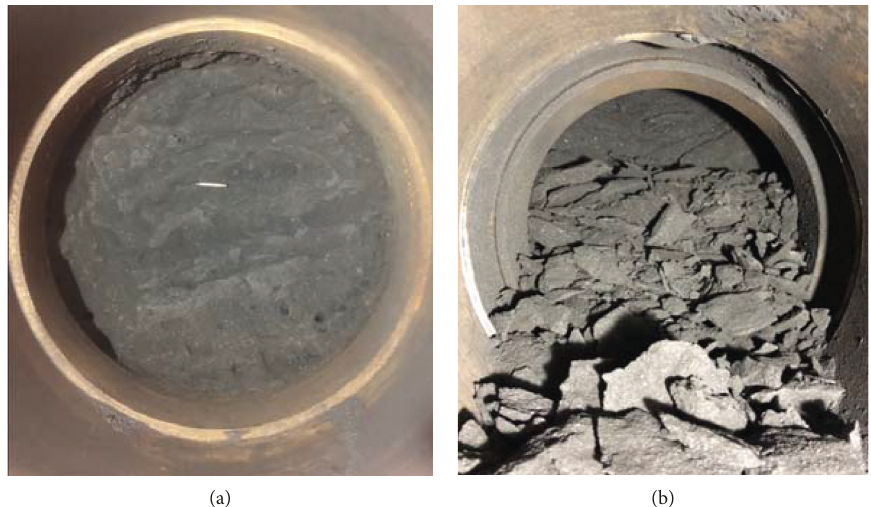
Figure 7: Variation characteristics of outburst hole before and after coal and gas outburst. (a) Before outburst. (b) After